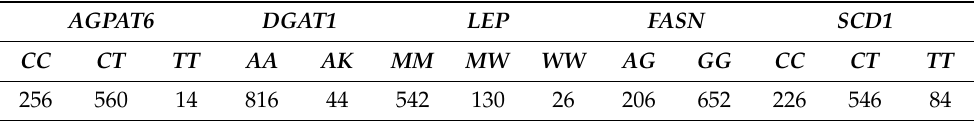
Table 1. Absolute frequencies of samples from cows with respective genotype 1